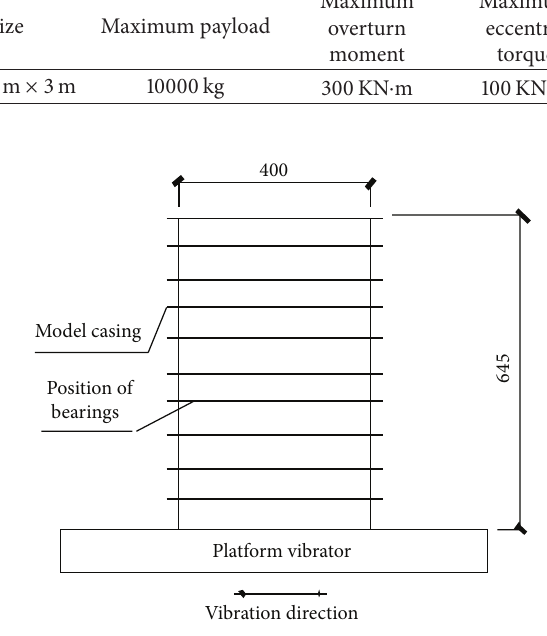
Figure 1: Sketch map of forced vibration specimen.